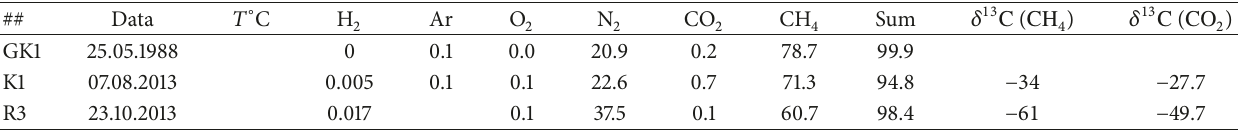
(a) Gas chemistry (vol % ) and carbon isotopic data of deep wells of the Koryaksky-Avachinsky volcanogenic basin, according to sampling data collected from 1988 to 2013. Wells: GK1, K1, and R3 (well positions are shown in Figure 1). GK1, G1, data from G. Ryabinin (pers. com., 2011); the remaining samples were collected by A. Kiryukhin and T. Rychkova. Chemical analyses were performed in the Central Chemistry Lab (Guseva V. I.). Isotopic analyses ( 𝛿 13 C) were performed by B. G. Pokrovsky